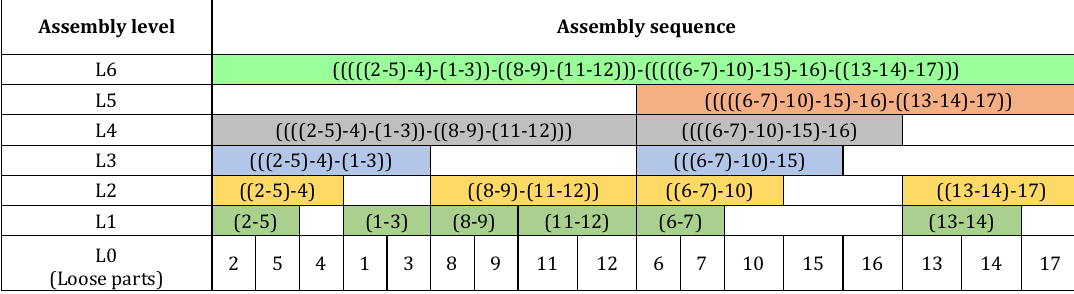
Table 4. ESWSA resulted optimal assembly sequence with level